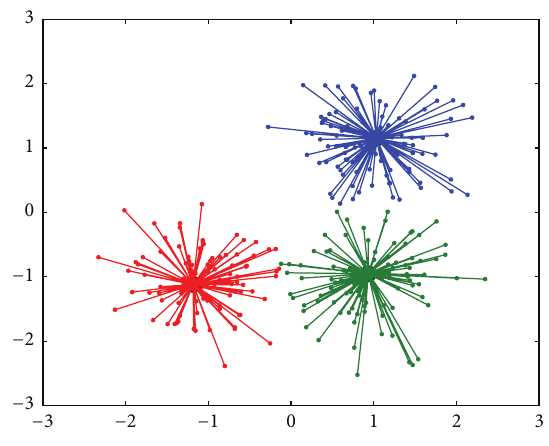
Figure 7: Affinity propagation demo